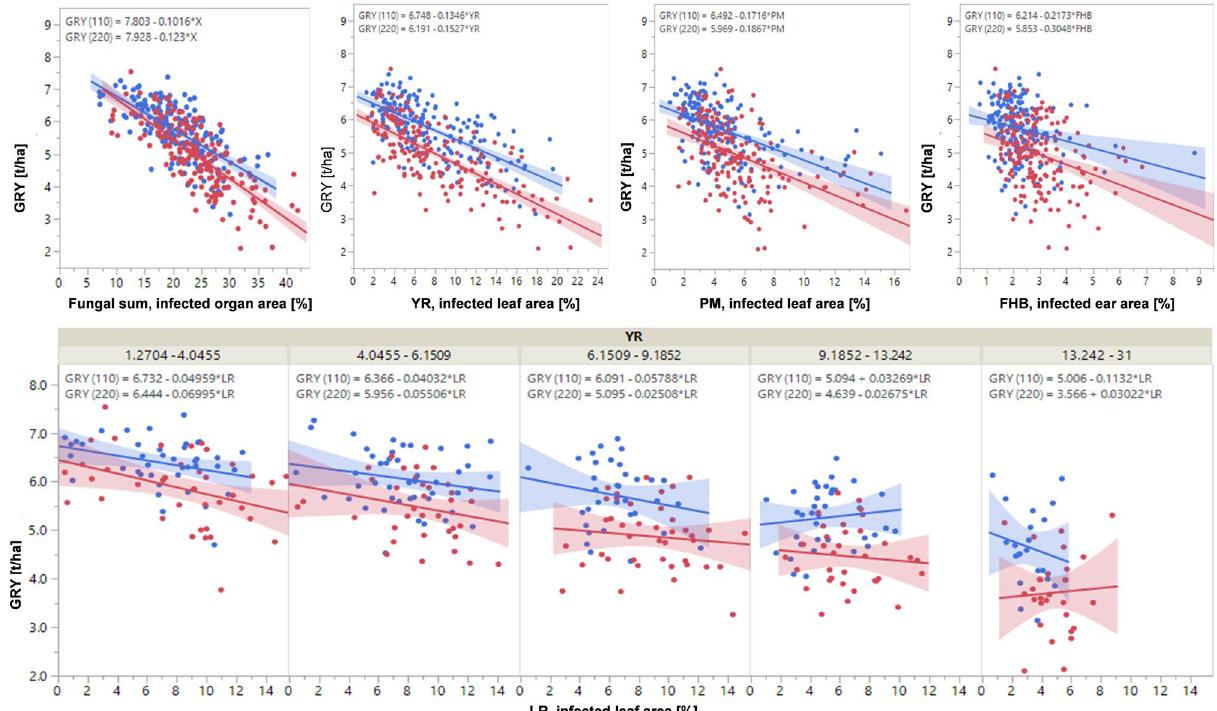
Figure 2. Bivariate analysis of grain yield (GRY, t/ha) in relation to fungal diseases as a group (Fungal sum), stripe rust (YR), powdery mildew (PM), and Fusarium head blight (FHB; all above), and partial bivariate analysis (below) of grain yield (GRY) in relation to leaf rust (LR) at five classes of YR infestation based on LSmeans (treatment-specific, over years and repeats). Each pair of analysed parameters with linear trend lines of low N (blue 110 kg N ha −1 ) and high N input (red 220 kg N ha −1 ), each trendline with 95% confidence interval. Equations of all trendlines are given above each